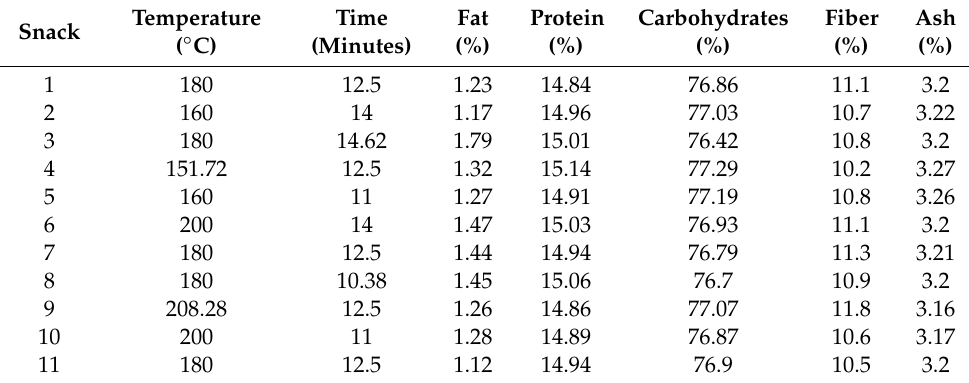
Table 1. Proximal composition of the snacks, and equations and modeled variations for the e ff ect of temperature and time on protein, carbohydrates, fiber, and ash.